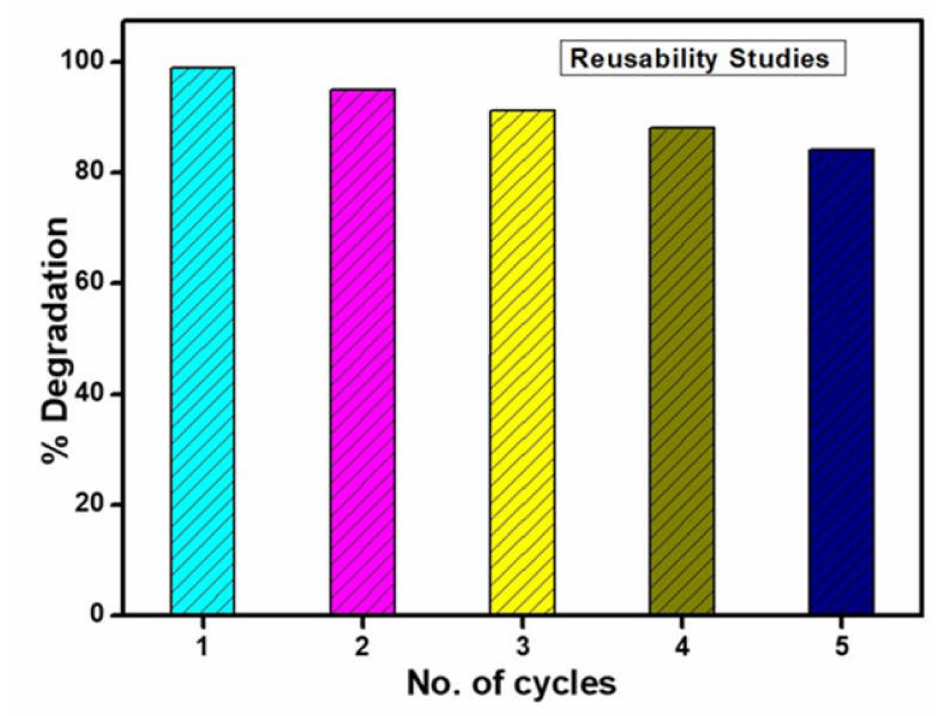
Figure 11. The recyclability study for the WS 2 -PANI-5 based photocatalytic material for the degrada- tion of MB. Table 2. Comparative study of the photocatalytic efficiencies of the different